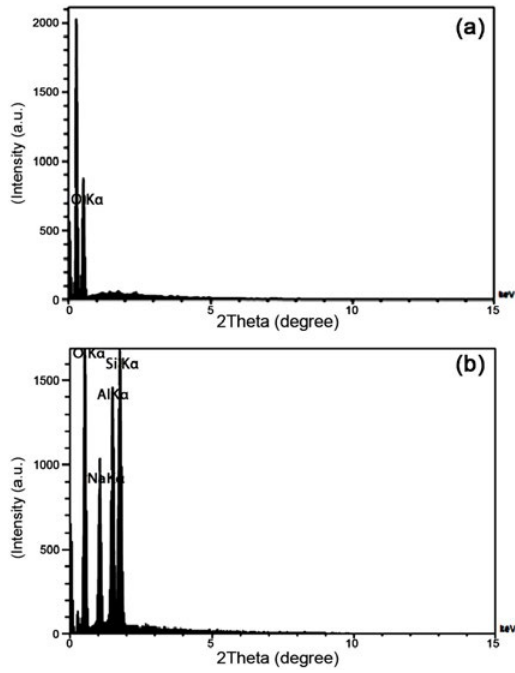
Fig. 2. EDS patterns of (a) GO and (b) zeolite N.P./PEG/GO nanocomposite